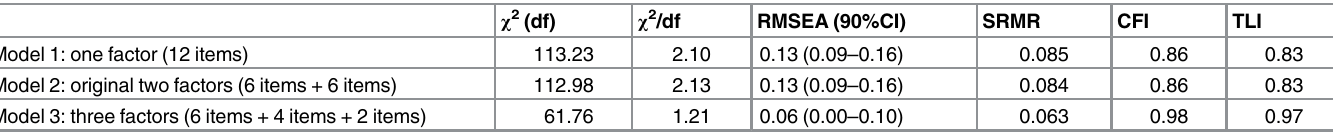
Table 4. Summary of goodness-of-fit indices for the three models of the